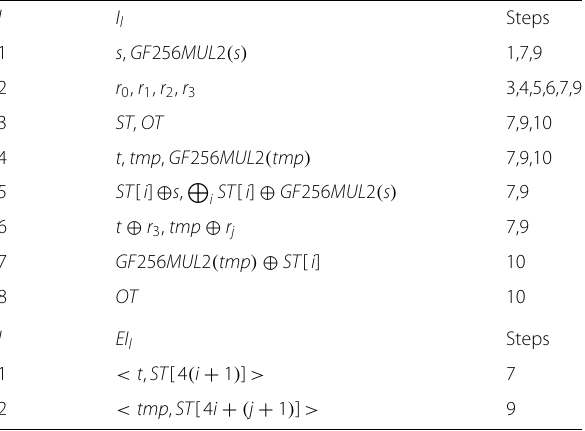
Table 3 Intermediate and extra variables of Algorithm